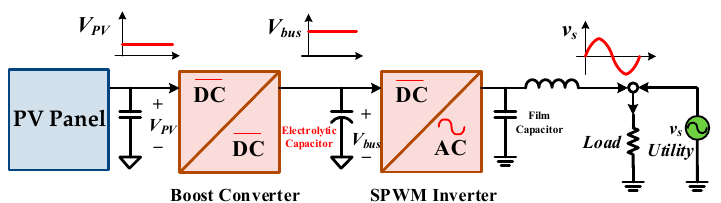
Figure 2. PV grid-connection systems with the two-stage cascade structure.